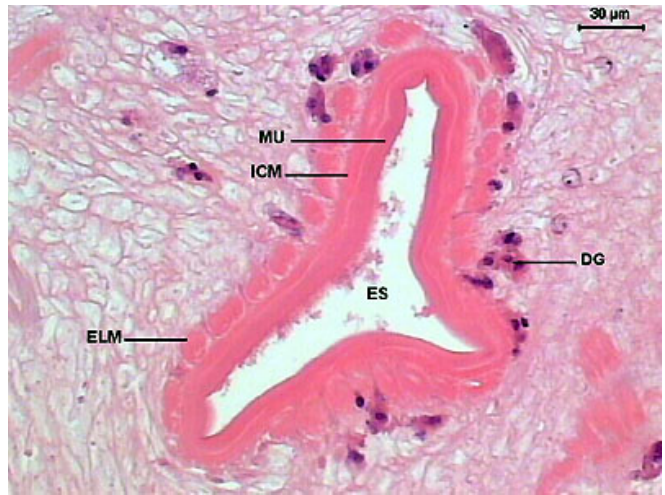
Figure 8. Transversal section of the initial portion of Sticholecitha serpentis esophagus. ES – esophagus, DG – digestive glands, MU – mucosa, ICM – internal circular musculature, ELM – external longitudinal musculature. HE.